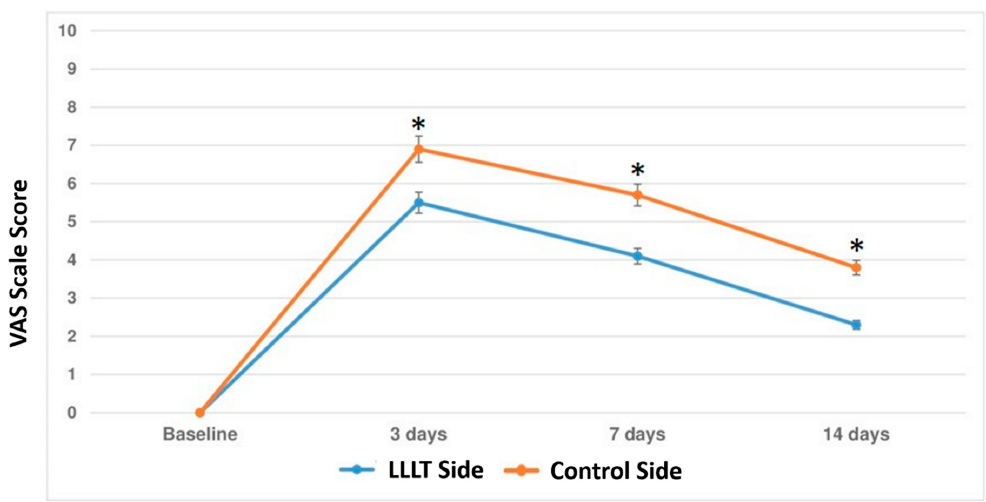
Figure 3. The results of the pain levels experienced in diode laser and control groups at each follow- up session (3, 7, and 14 days). Error bars represent the Standard Deviation (± SD). *, p < 0.001, comparison between groups at each follow-up